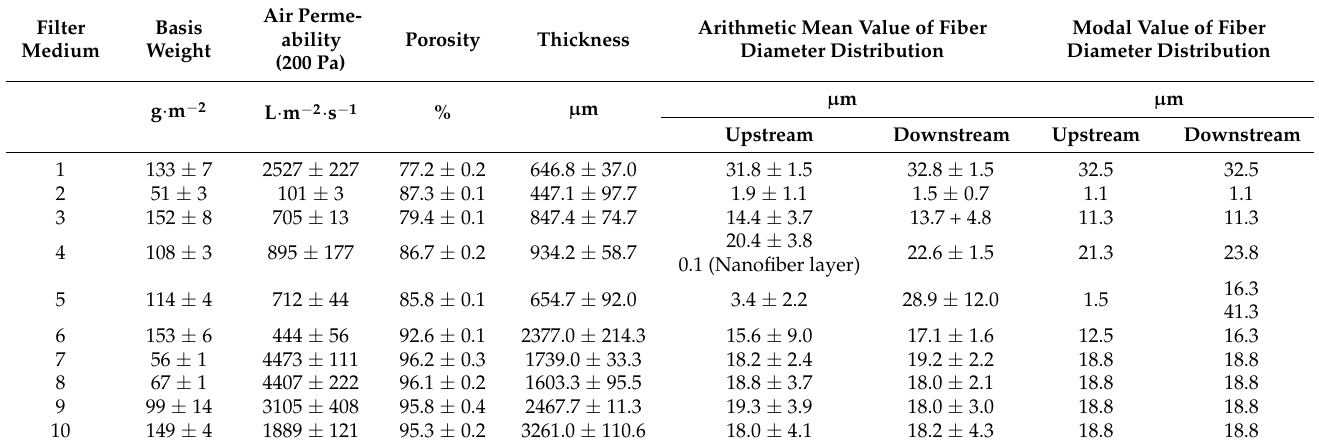
Table 2. Air permeability and parameters of fibrous structure of the investigated filter media.